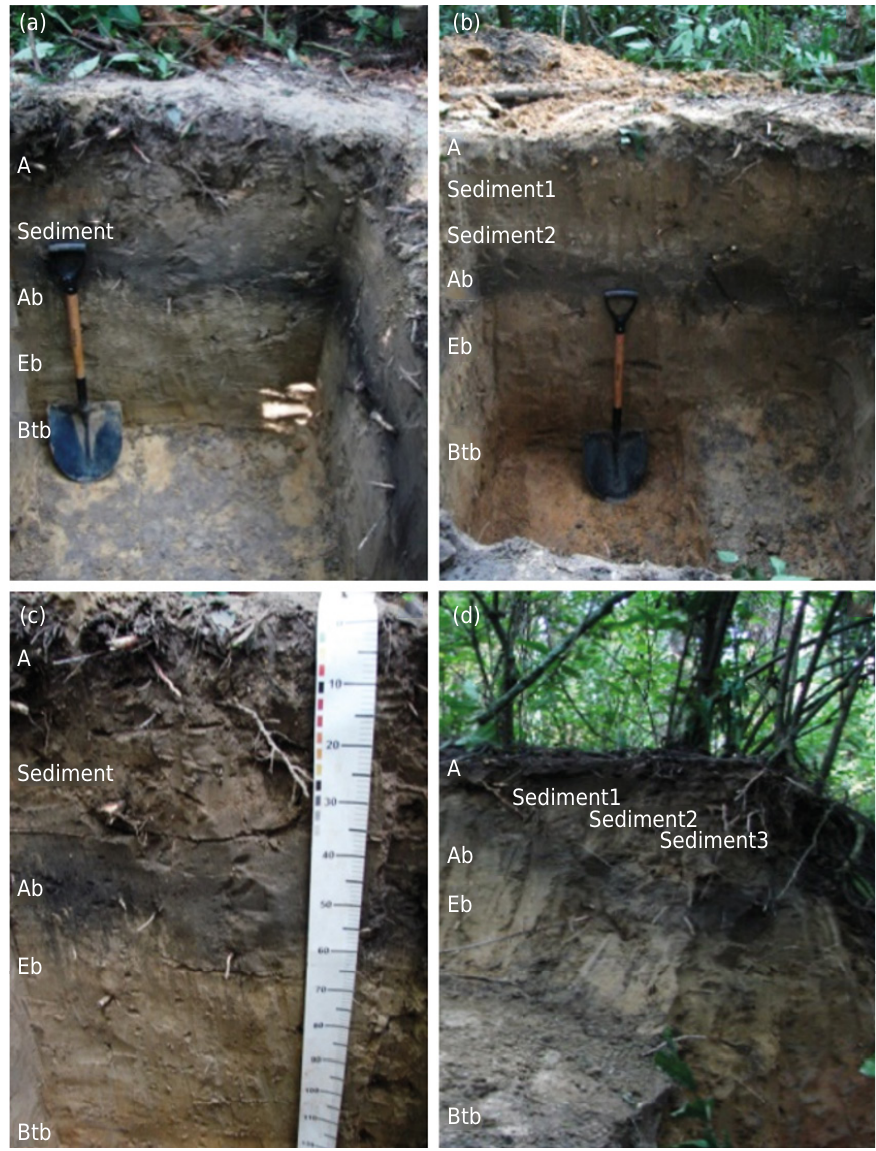
Figure 2. Images of the studied pits: soil horizons and sediment layers. (a) Pit 1 - T1; (b) Pit 2 - T2; (c) Profile 1 - P1; and (d) Profile 2 -